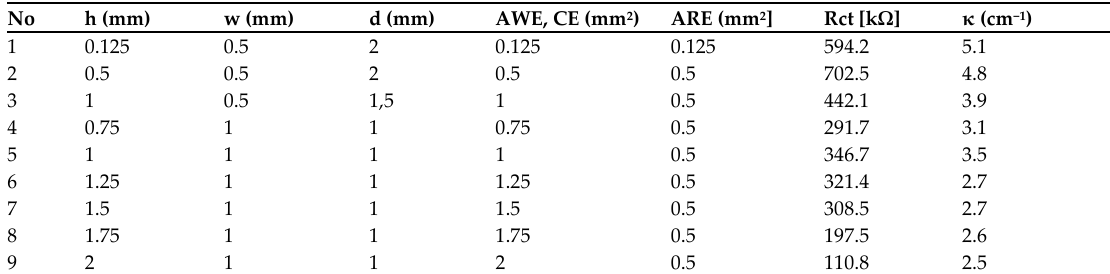
Figure 1. ( a ) Design of integrated electrochemical cell fabricated LTCC technology; ( b ) Photograph of all types of integrated electrochemical cell fabricated LTCC technology; ( c ) Schematic drawing presenting the integrated electrochemical cell dimensions. Table 1. Dimensions of the integrated electrochemical sensors and calculated values of R ct for 𝒄 𝑭𝒆 𝟐+/𝟑+ = 1.17 mmol/dm 3 and cell constant, where h—height of WE and CE, w—width of WE and CE, d—distance between and CE, A WE,CE —area of WE and CE, A RE – area of RE, R ct —charge transfer resistance, κ —cell